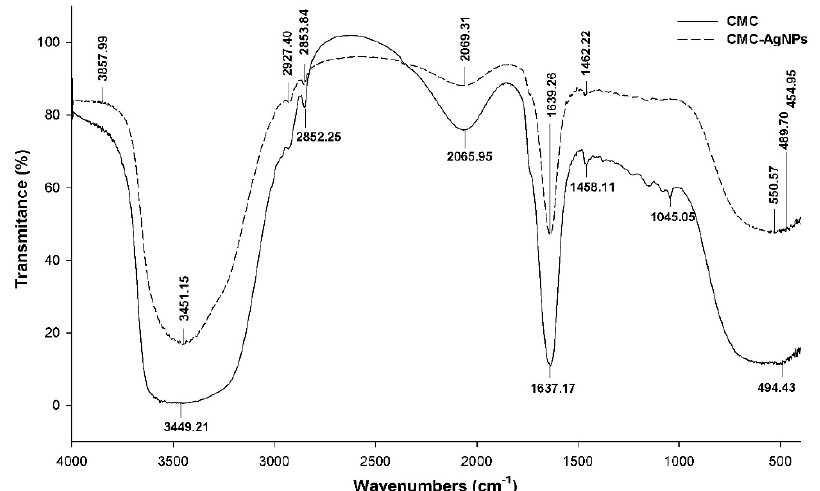
Figure 3. Fourier-transform infrared (FTIR) absorption spectra of CMC coating base (solid line) and CMC-AgNPs (dashed line).